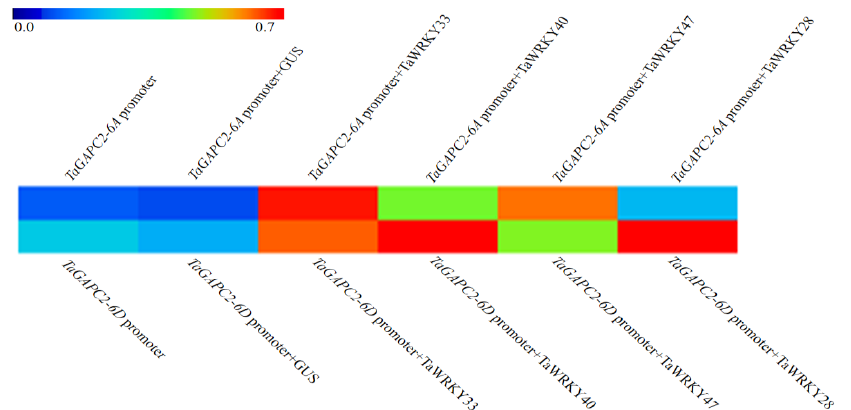
Figure 3. Rluc / Fluc value analysis of the interaction between TaWRKYs and TaGApC2 promoters of Chinese spring wheat. TaGApC2-6A promoter and TaGApC2-6D promoter. The GUS effector was used as internal control. The data represent three independent experiments. The standard deviation (SD) is indicated at each point. Significant differences were assessed by one-sided paired t -tests.